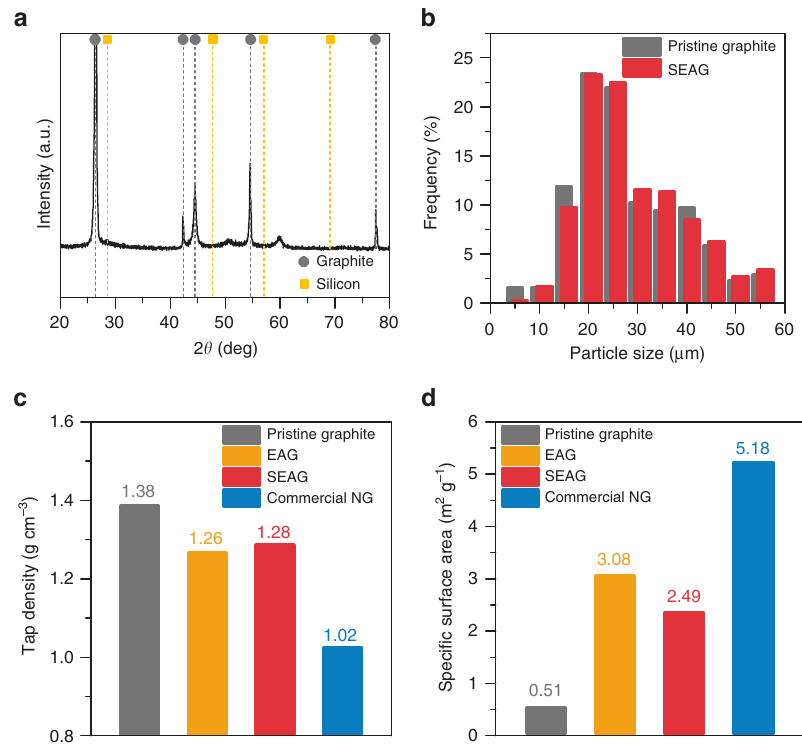
Fig. 2 Physical properties of SEAG. a XRD pattern of SEAG. b Statistical analysis of the particle-size distribution of pristine graphite (gray) and SEAG (red). c Tap density and d speci fi c surface area of pristine graphite (gray), EAG (orange), SEAG (red), and conventional NG (blue)